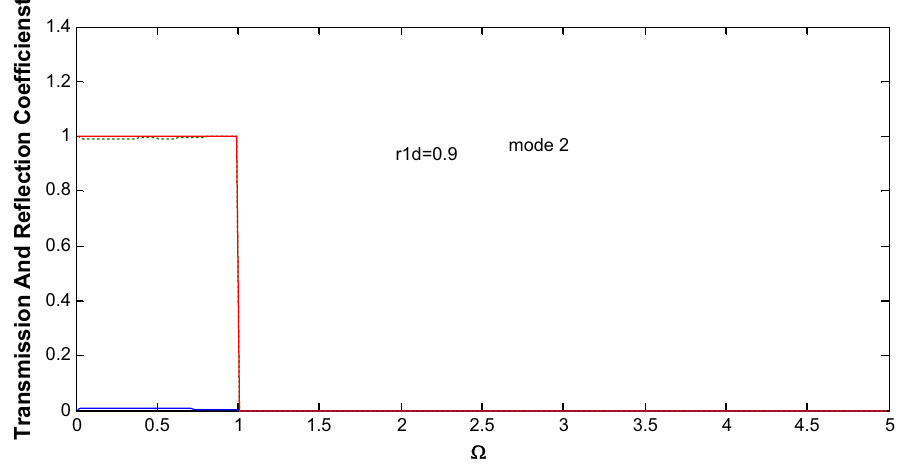
Figure 8: Transmission and re fl ection coe ffi cients in the case of softening mode 2.